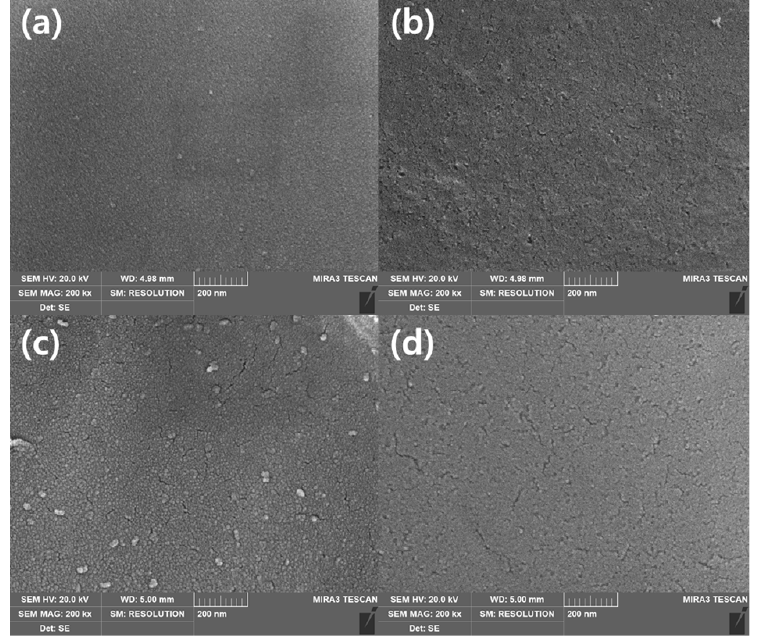
Figure 5. The scanning electron microscopy (SEM) of activated carbon: ( a ) CM-DTH, ( b ) CM-DTHC- 300 (1:1), ( c ) CM-DTHC-300 (1:2), ( d ) CM-DTHC-300 (1:3).